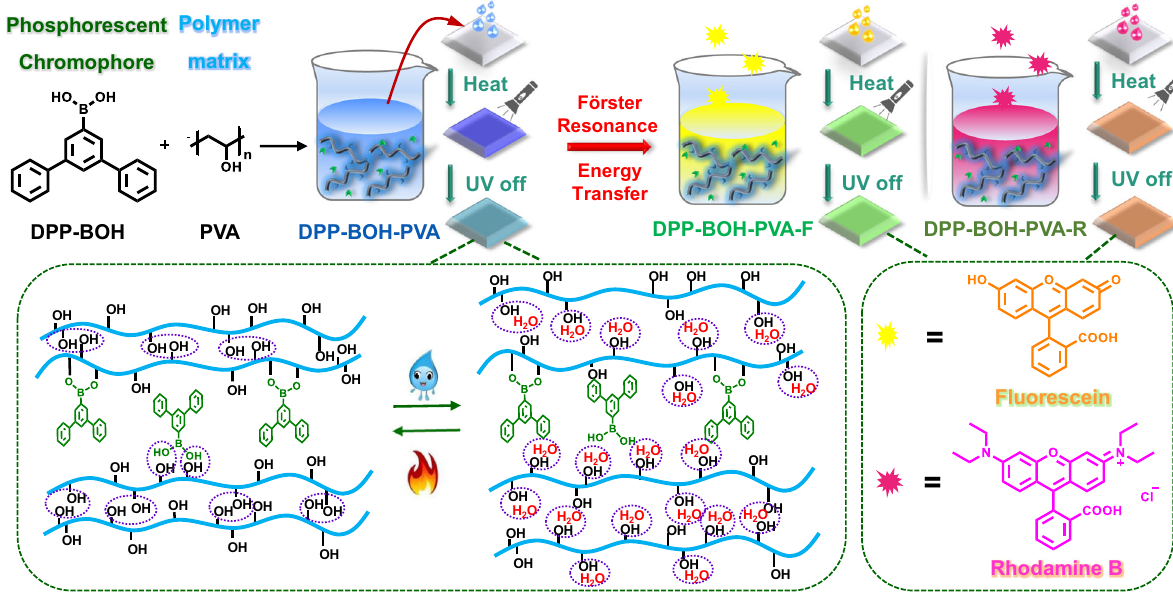
Fig. 1 Stimulus-responsive room-temperature phosphorescent system. Schematic illustration of the synthetic process of three target products and changes in intermolecular interactions under heating or water